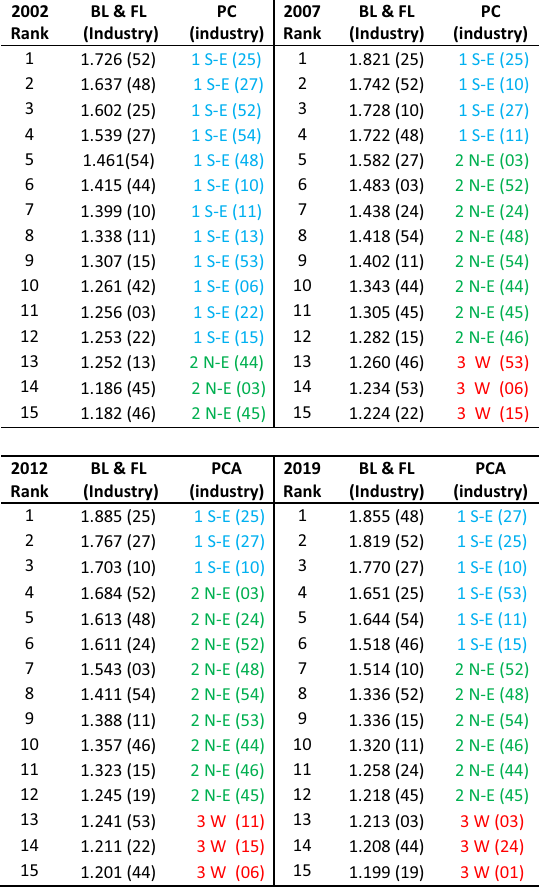
Table 1 Ranking of industries through linkages and PCA